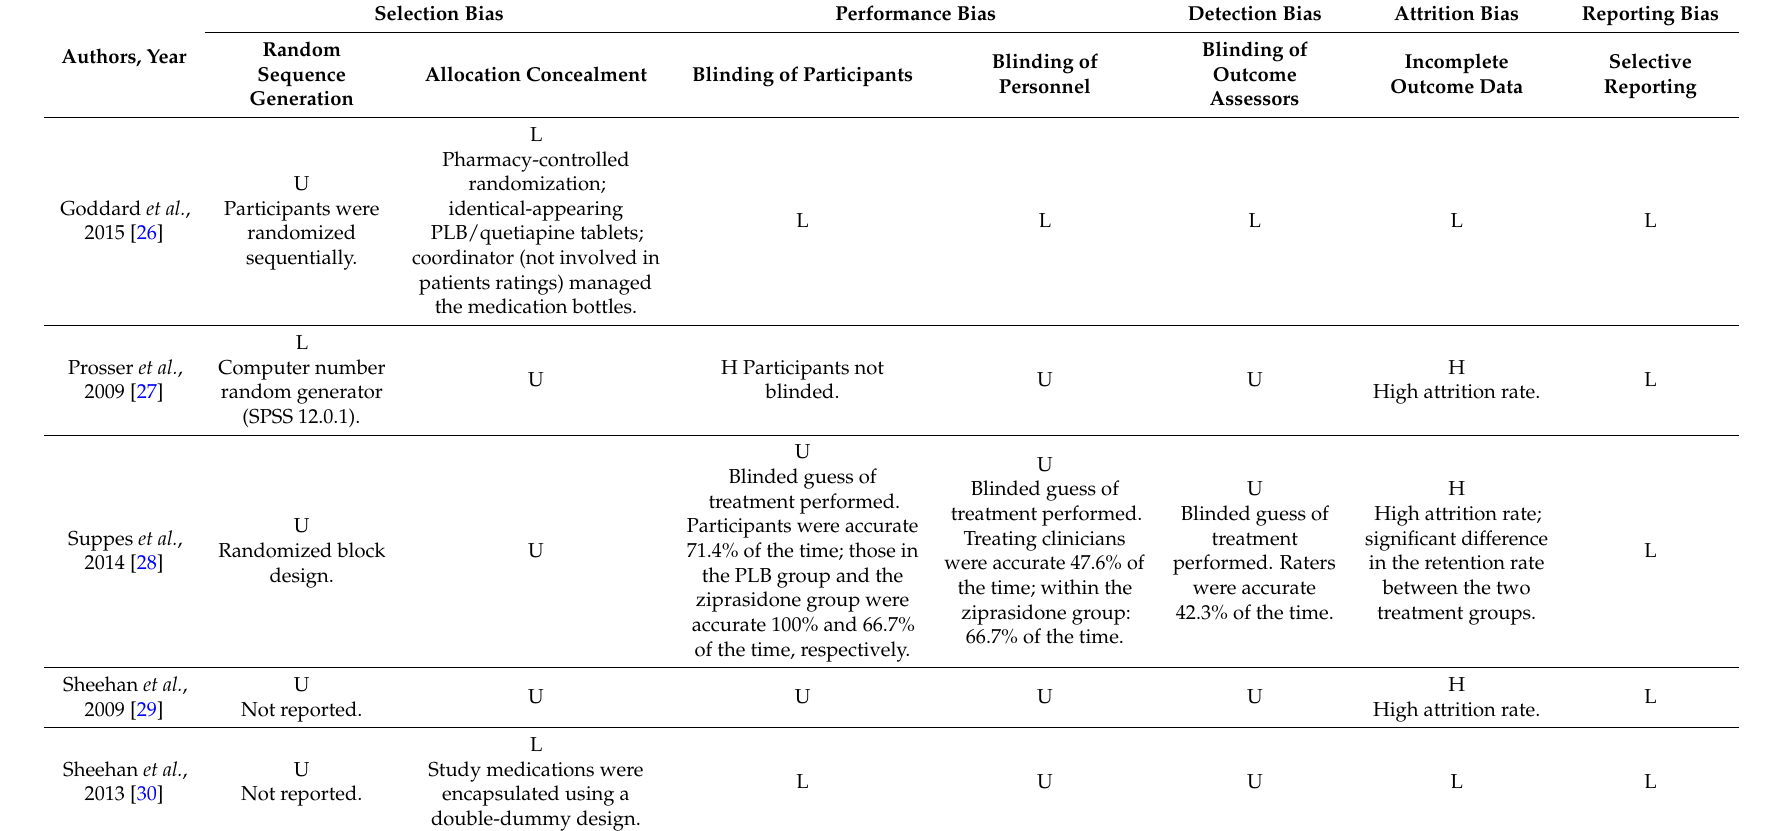
Table 2. Risk of bias in individual